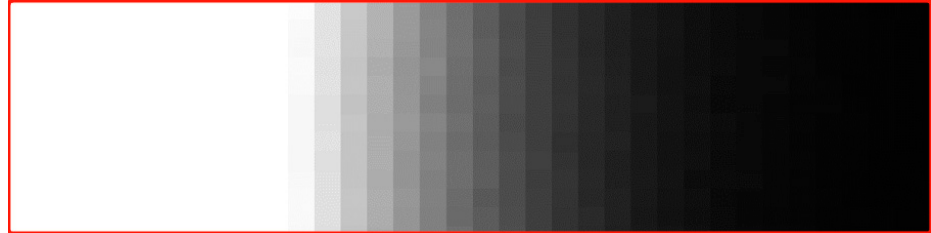
Figure 6. The edge transition area.